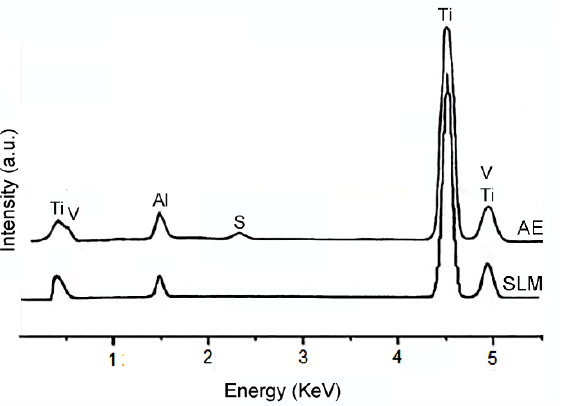
Figure 3. EDX-SEM spectra of the surface of SLM and AE samples.